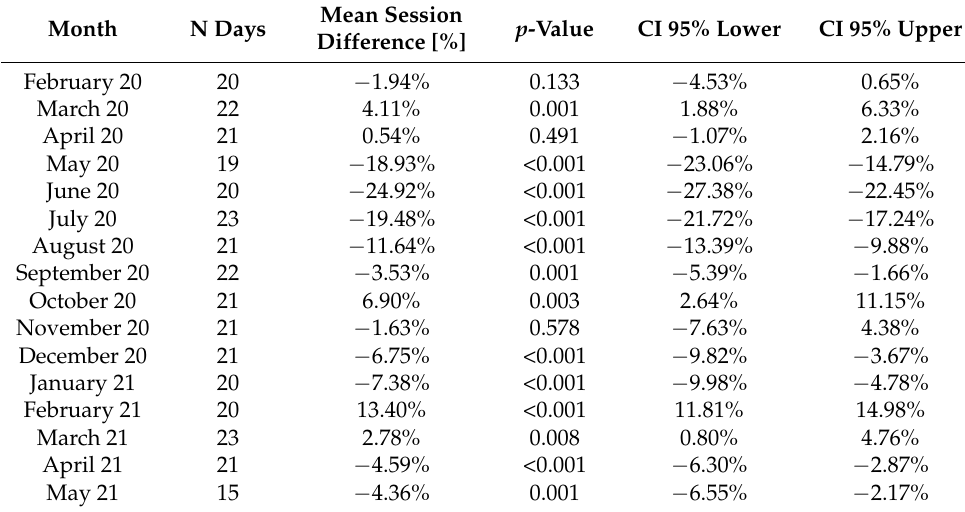
Table 1. Relative difference of daily RT session counts during the COVID-19 epidemic in comparison to the corresponding pre-pandemic reference